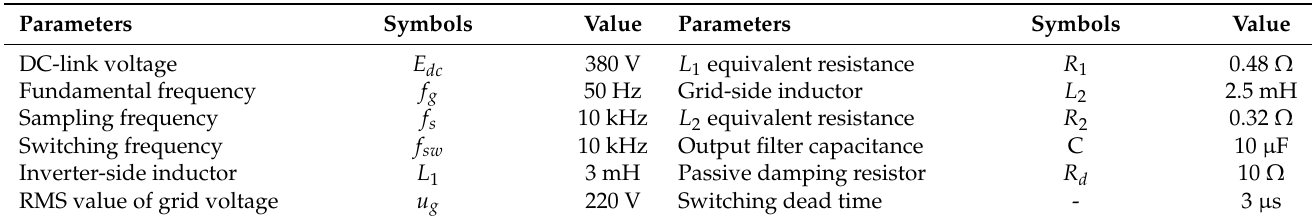
Table 1. System parameters.